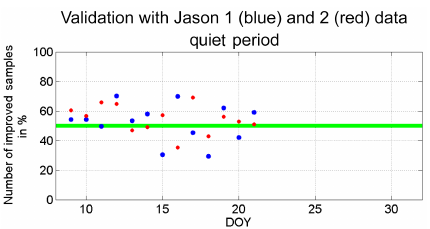
Figure 11. The percentage number of reduced absolute Jason resid- uals per day of the quiet DAIS period.